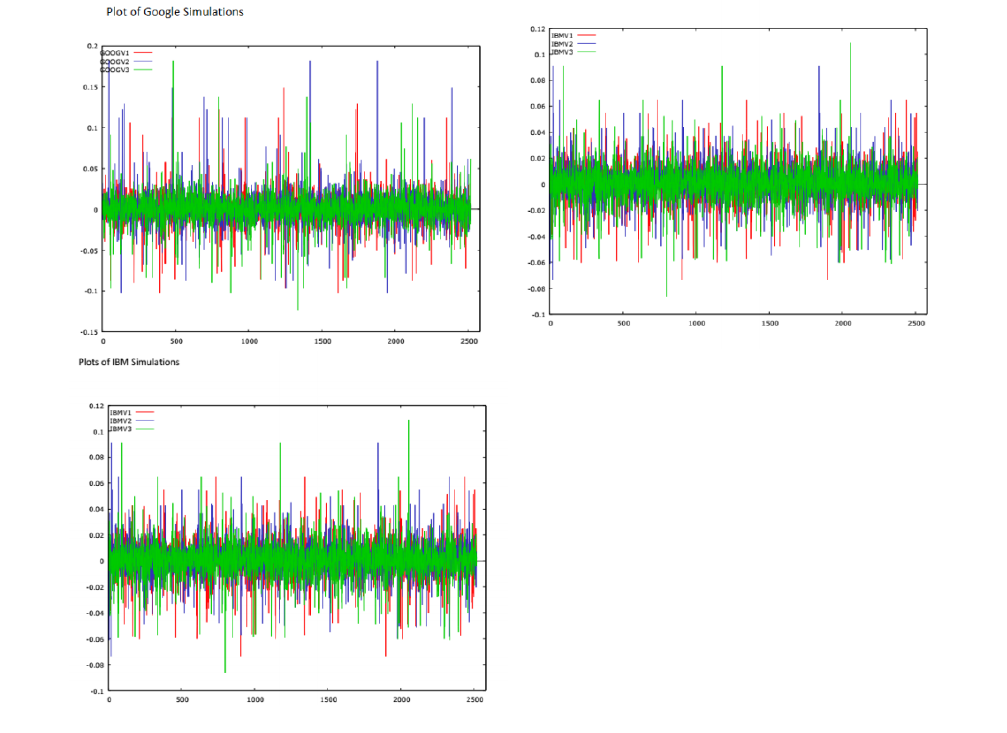
Figure 3. Simulated time series of